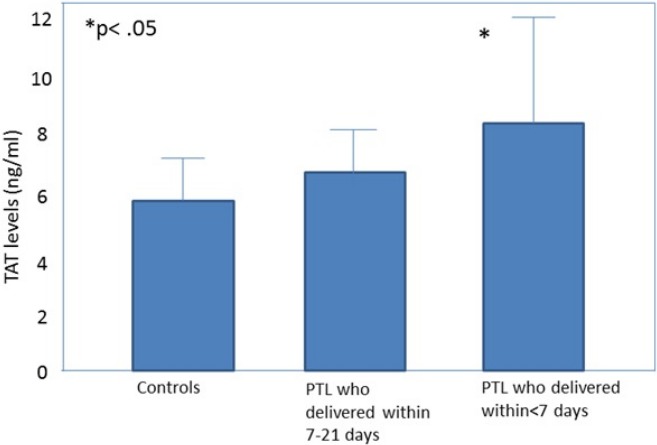
Thrombin–antithrombin (TAT) III levels in control patients, patients with preterm labor who delivered between 21 and 7 days, and patients with preterm labor who delivered within 7 days from admission.Open diamonds, mean levels; black error bars, SD. ∗P < .05, Student-Newman-Keuls method. From Elovitz, Baron & Phillippe (2001).